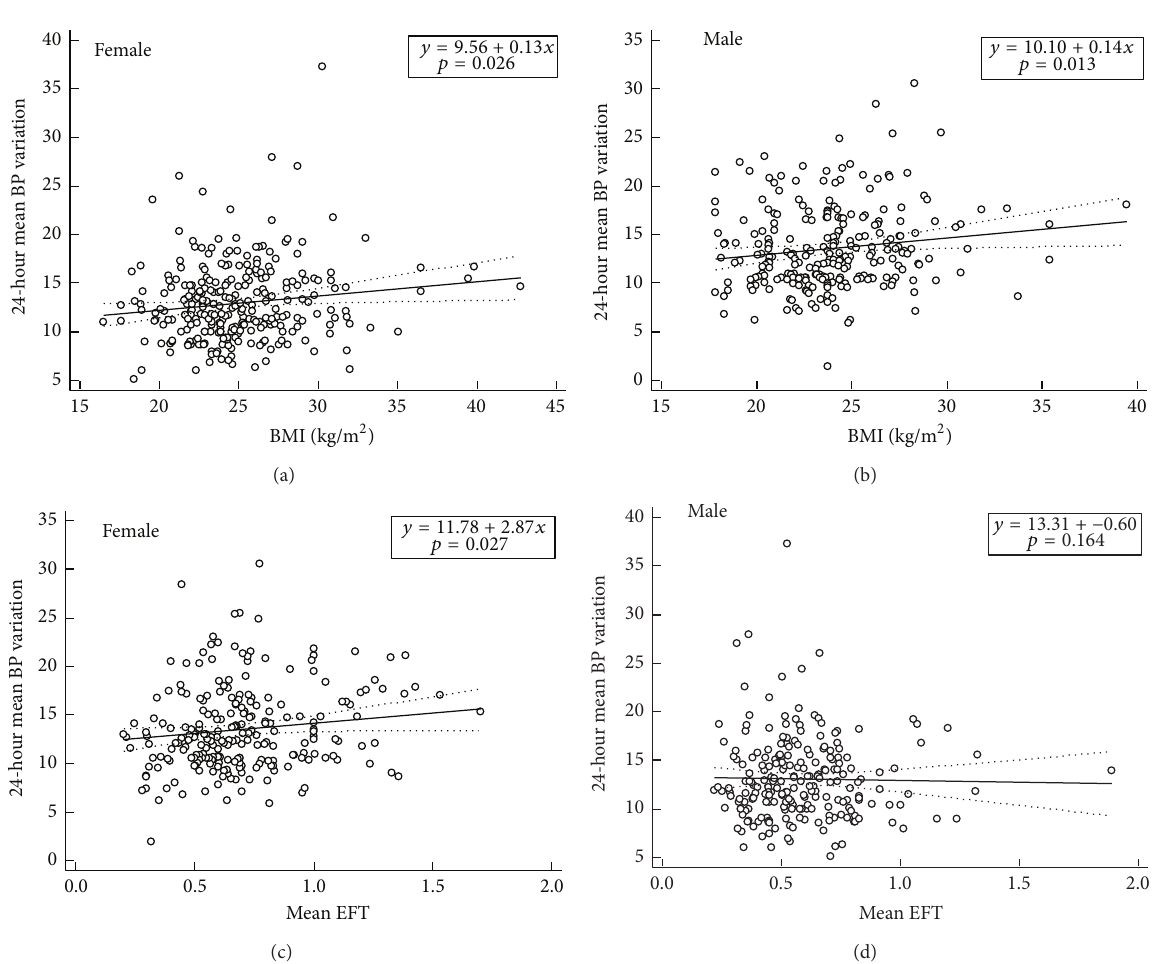
Figure 2: Regression analysis between 24-hour mean blood pressure (BP) difference and body mass index (BMI) or mean epicardial fat thickness(EFT).24-hourmeanBPvariationwassignificantlyrelatedtoBMIinbothfemales(a)andmales(b).However,EFTwassignificantly correlated with 24-hour mean BP variation only in females (c), not in males